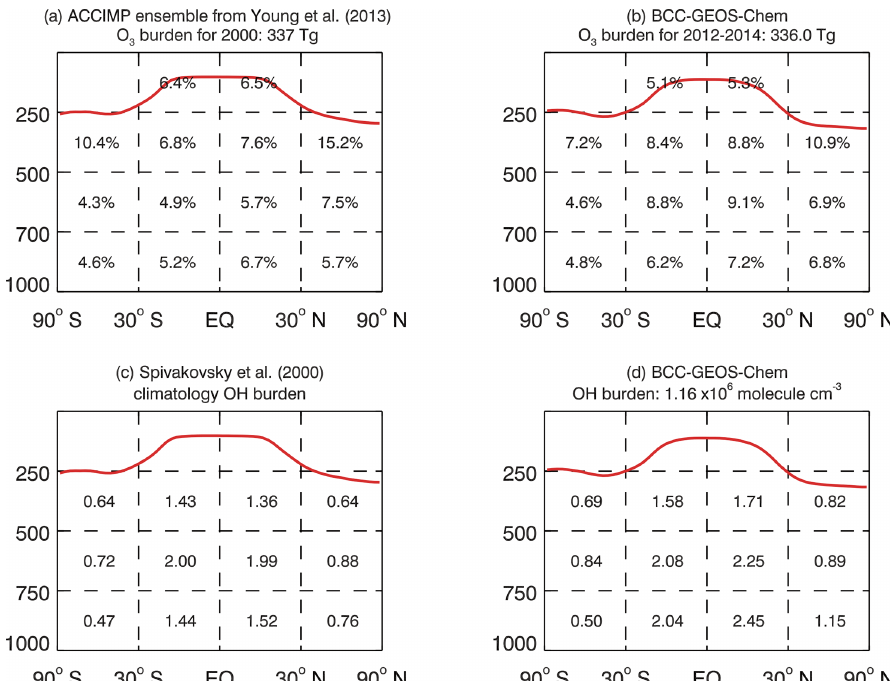
Figure 8. Zonal and vertical distributions of the tropospheric ozone burden and OH concentrations. For comparison, panel (a) shows tro- pospheric ozone burden in the year 2000 from Young et al. (2013) based on 15 ACCMIP models, and panel (c) shows the climatological tropospheric OH burden reported by Spivakovsky et al. (2000) and summarized by Emmons et al. (2010). Panel (b) and (d) show corre- sponding results from BCC-GEOS-Chem v1.0 averaged over 2012–2014. The red lines in (a) and (c) denote the tropopause derived from the National Centers for Environmental Prediction (NCEP) reanalysis, and those in (b) and (d) are from BCC-GEOS-Chem v1.0.